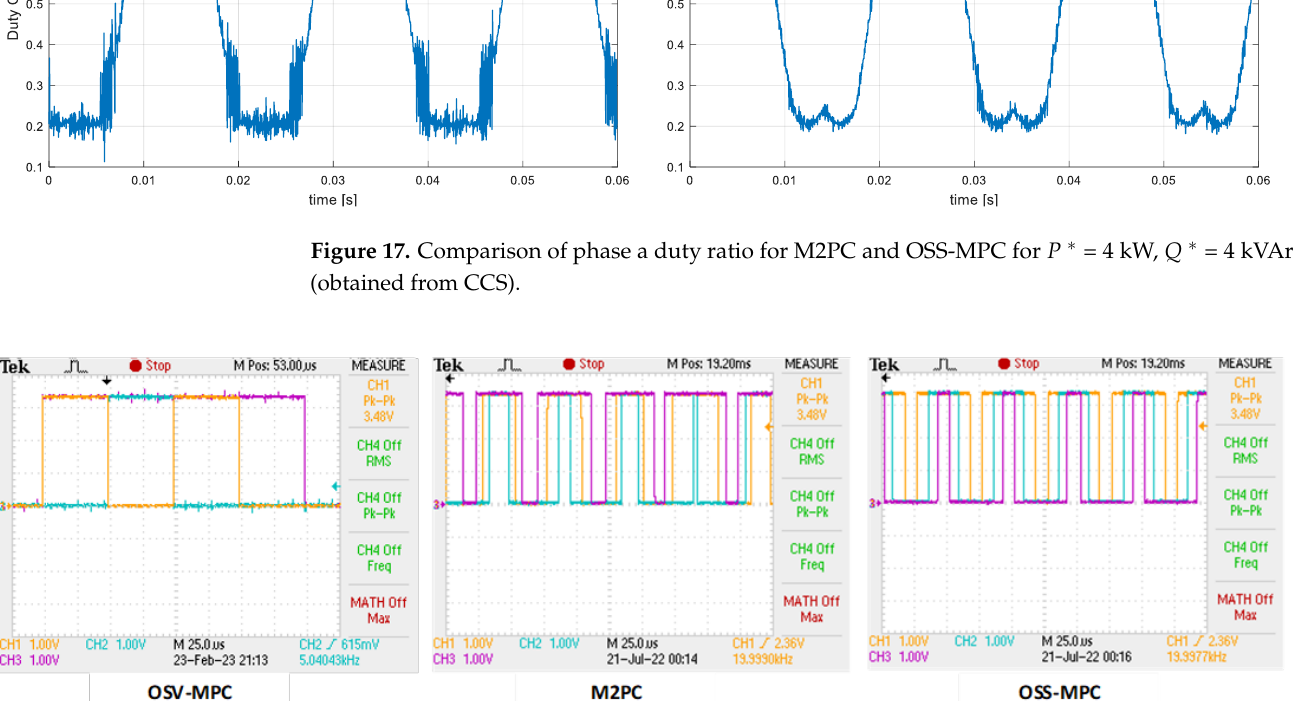
Figure 18. Comparison of switching pattern for each FCS-MPC